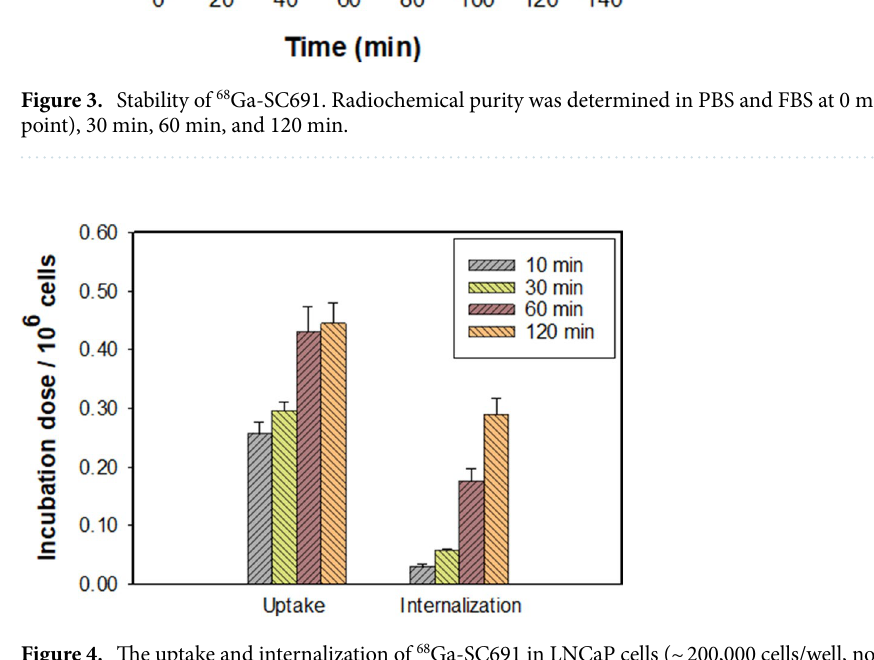
Figure 4. The uptake and internalization of 68 Ga-SC691 in LNCaP cells (~ 200,000 cells/well, normalized to 10 6 cells) at 10 min, 30 min, 60 min, and 120